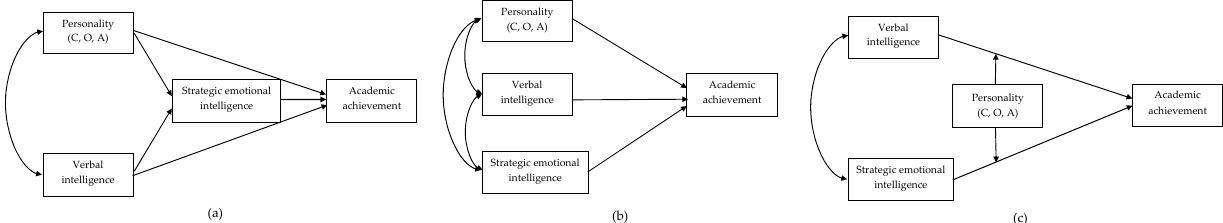
Figure 1. Theoretical models of the interaction between strategic EI, verbal intelligence, and personality in predicting academic achievement: ( a ) mediation model; ( b ) direct effects model; ( c ) moderation model. Note. In model ( a ), C is assumed to have only a direct effect on academic achievement, while for O and A, both direct and indirect effects are hypothesized.